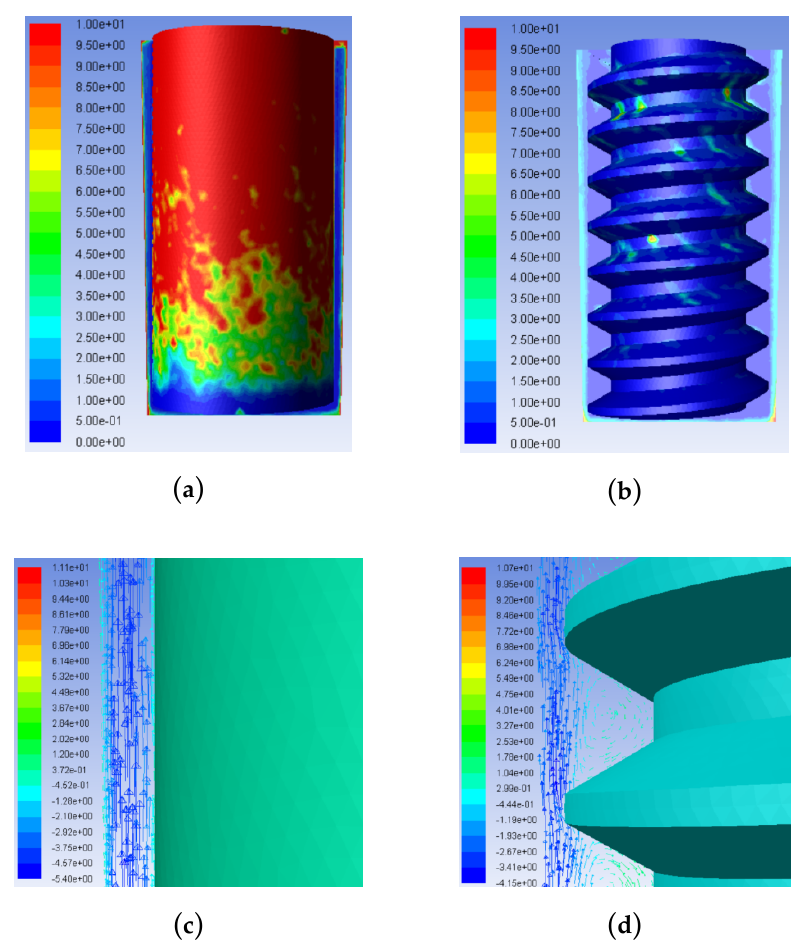
Figure 14. Comparison of simulation results with different tool tube electrodes: Product concentration contours with ( a ) trapezoidal helical electrode and ( b ) ordinary cylindrical electrode. Vectors of velocity in machining gap with ( c ) trapezoidal helical electrode and ( d ) ordinary cylindrical electrode.